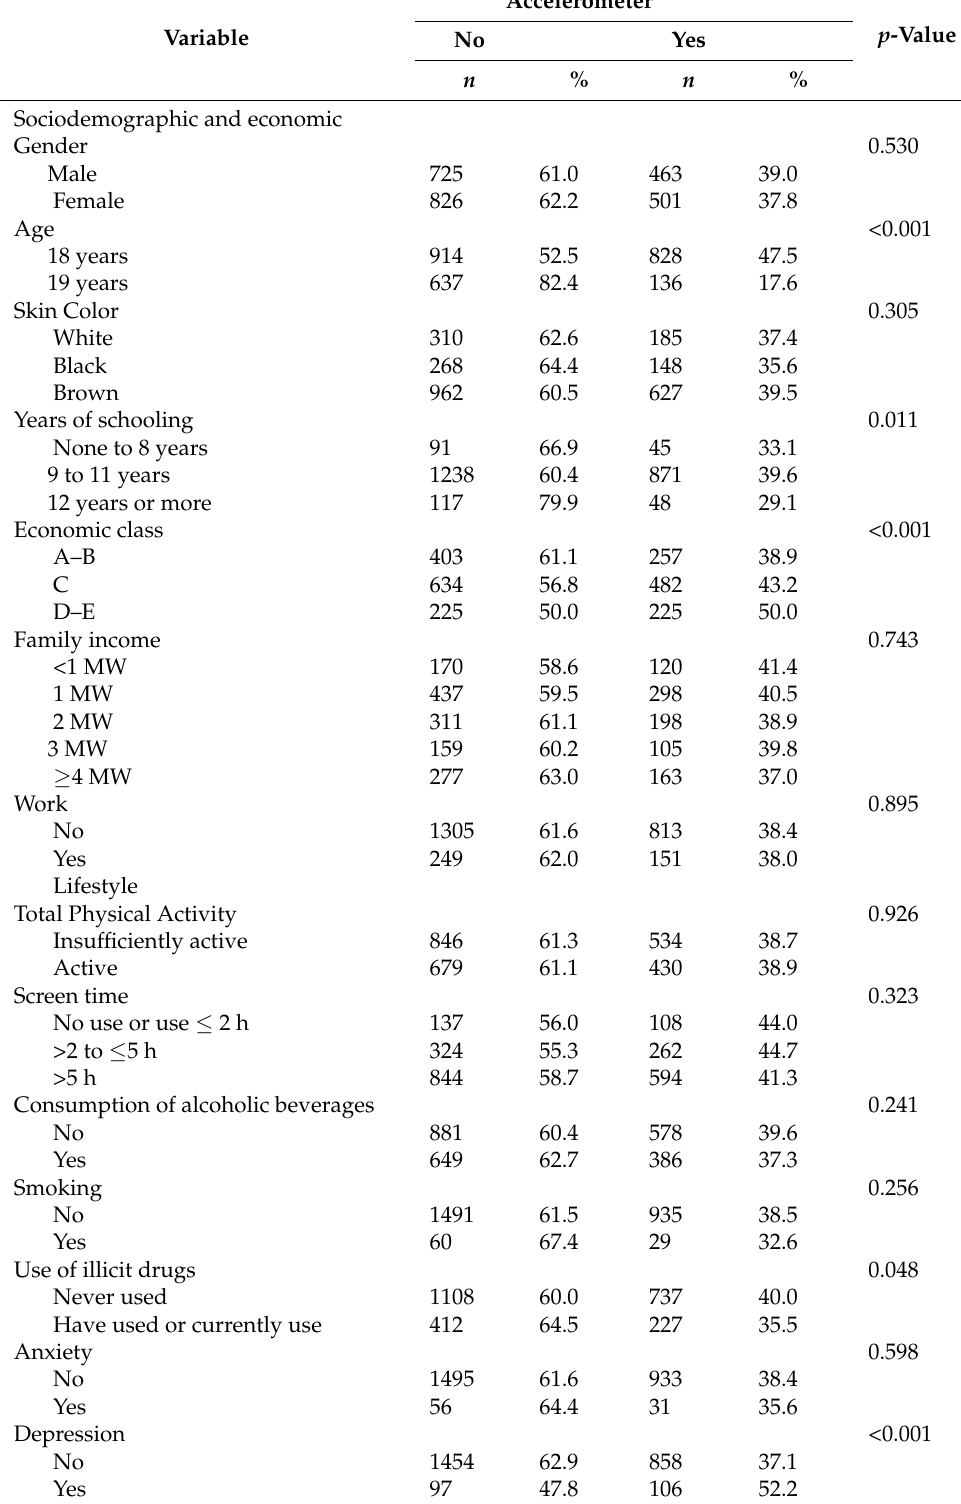
Table 1. Sample distribution ( n = 2515) according to the use or not of accelerometers in adolescents. S ã o Lu í s, Maranh ã o, Brazil,